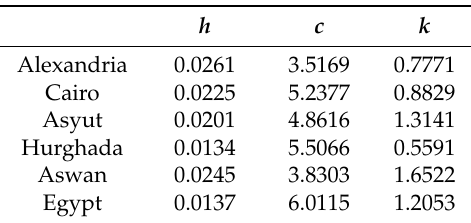
Table 8. Constants of the two distributions that characterize the AOD over the different cities (see the text for explanation of the symbols).